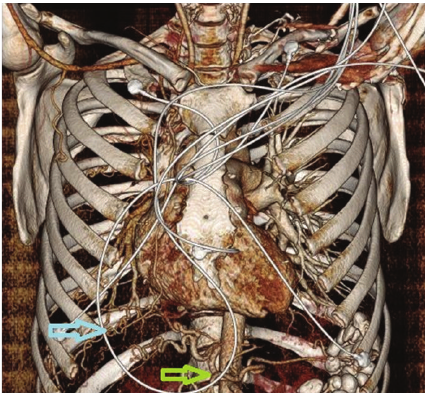
Figure 5: Three-dimensional reconstructed image showing origin of anomalous artery (green arrow) supplying diaphragmatic col- laterals. Phrenic-pulmonary arcades and marginal pulmonary sys- temic shunts (blue arrow) are seen draining via the small right pulmonary